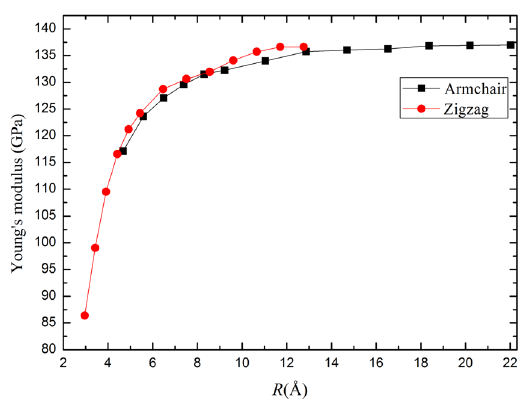
Figure 5. The dependence of Young’s modulus for PNTs on